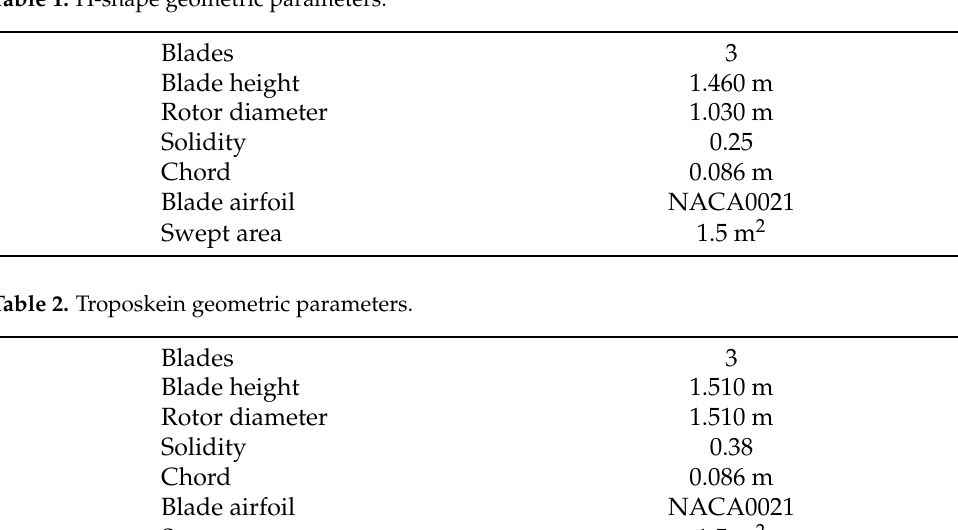
Table 1. H-shape geometric parameters.